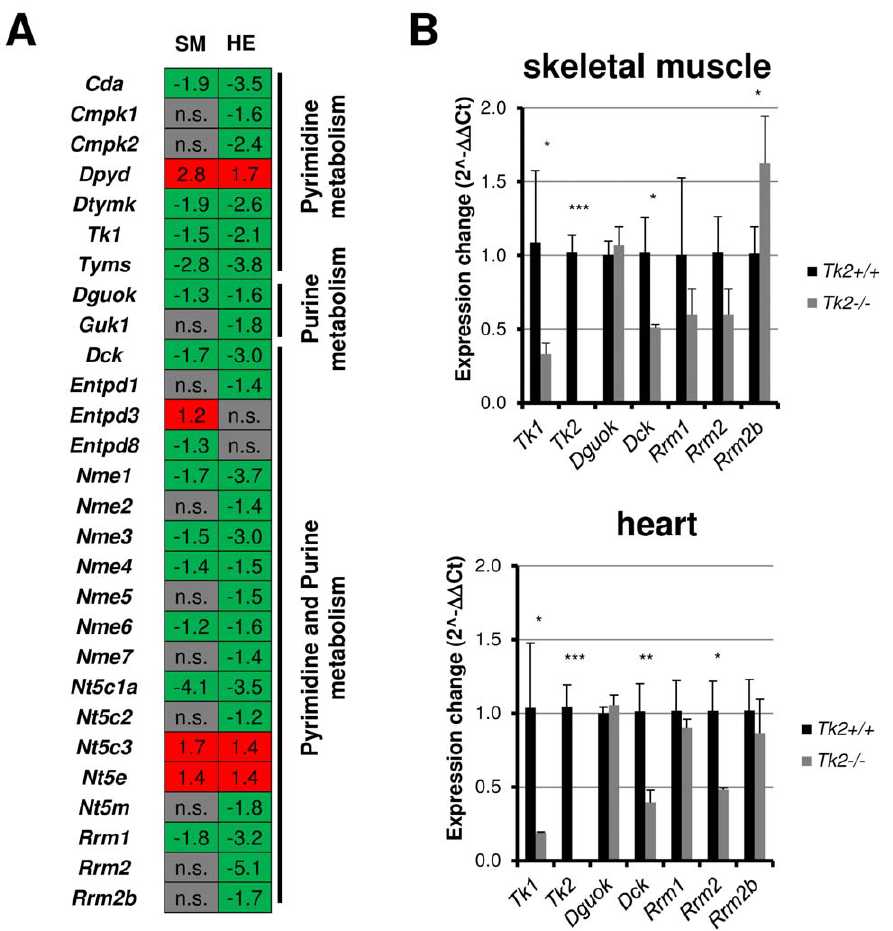
Figure 5. dNTP pool maintenance related genes expression variation in both skeletal muscle and heart of 11 days-old Tk2 knockout ( Tk2 2 / 2 ) mice. A ) Gene variation obtained by microarray analysis. SM and HE refer to each of the gene expression analyses made, in skeletal muscle and in heart. n.s. indicates that the gene is not significantly up- or down-regulated in the analysis. B ) Expression of deoxyribonucleoside kinases genes was also analysed by Real-time qPCR. The P -values for statistical comparisons (two-tailed unpaired Student’s t-test) between Tk2 + / + and Tk2 2 / 2 tissues are shown - * P , 0.05; ** P , 0.01; *** P , 0.001.